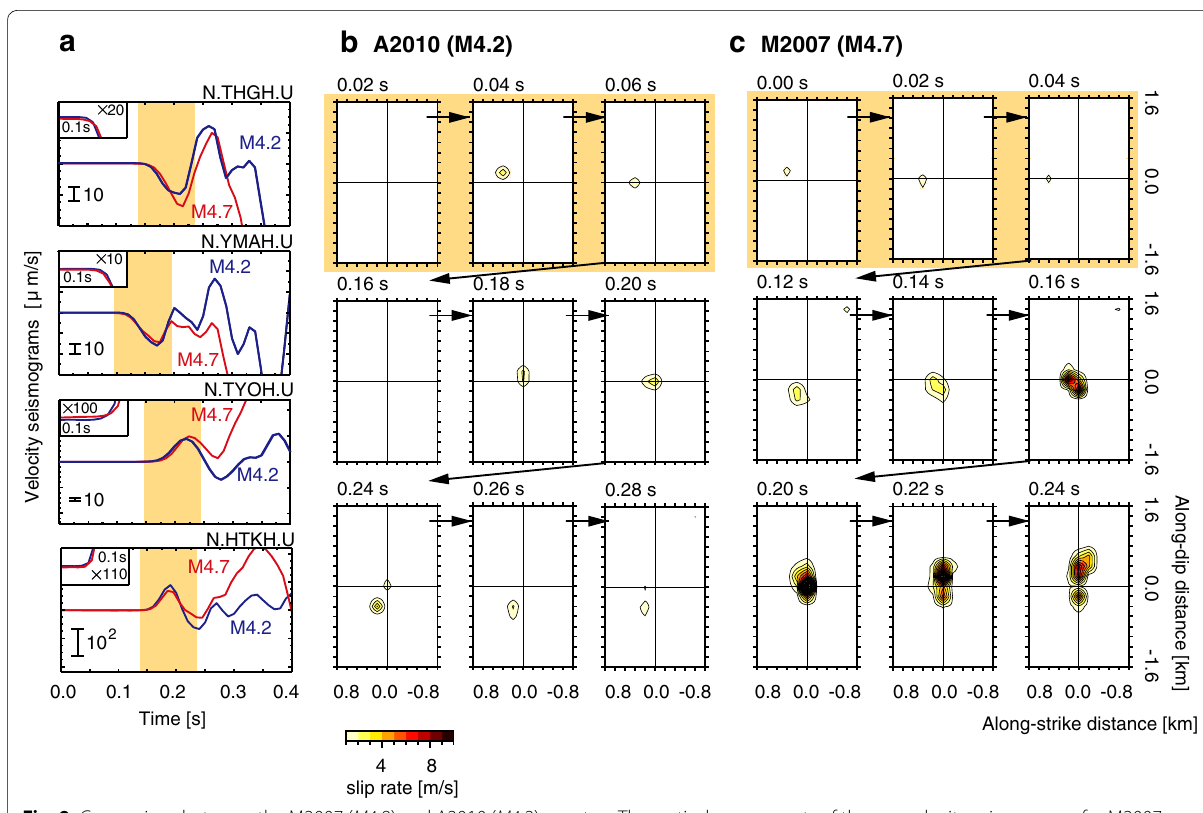
Fig. 9 Comparison between the M2007 ( M 4.8) and A2010 ( M 4.2) events. a The vertical components of the raw velocity seismograms for M2007 and A2010, with the onset of the P-wave responses magnified in the inset. The orange zones mark the 0.1-s time interval where the larger and smaller events possess similar initial seismic responses. Slip rate histories for b M2007 and c A2010, projected onto common spatial coordinates. The highlighted slip history panels indicate the near-identical early slip